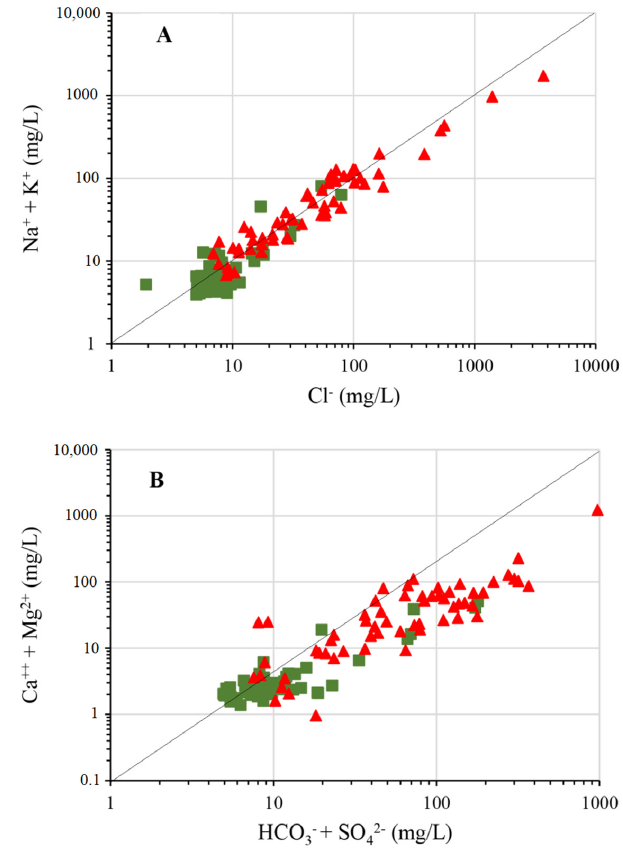
Figure 9. Bivariate plots of ionic relation. ( A ) Na + + K + versus Cl-. ( B ) Ca 2+ + Mg 2+ versus HCO 3 − + SO 4 2 − for coastal aquifers in Benin. The bisector represents the 1:1 dissolution line.